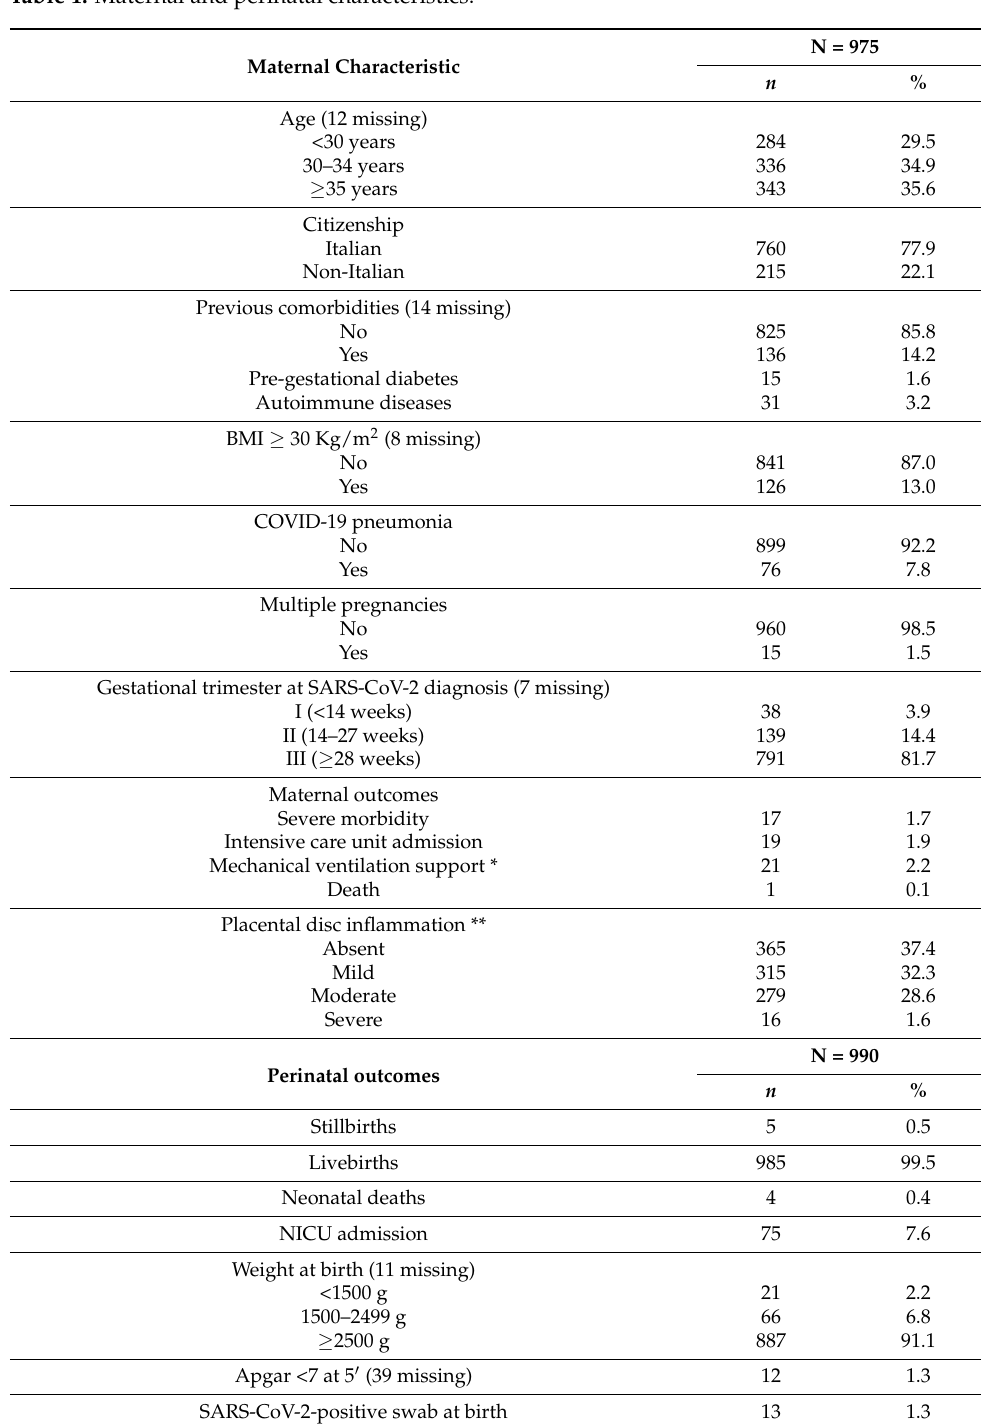
Table 1. Maternal and perinatal